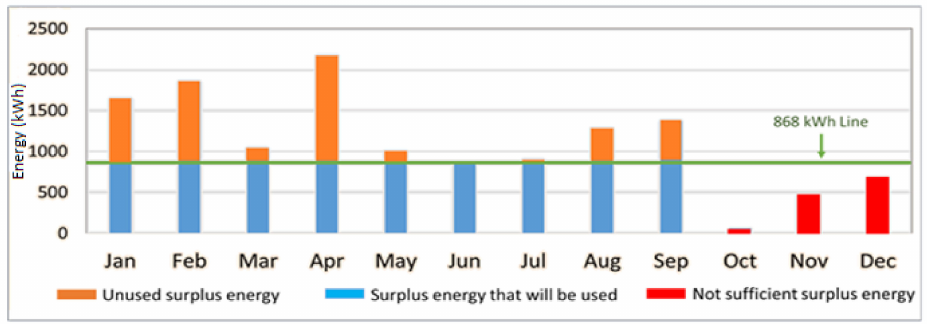
Figure 16. Selected CSS process energy